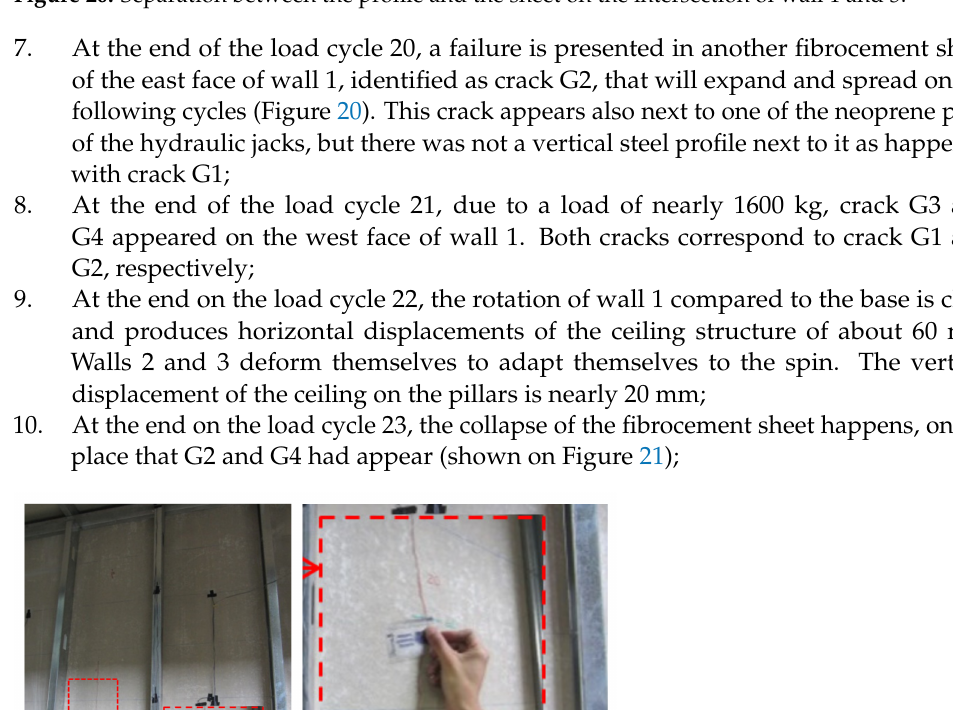
Figure 20. Separation between the profile and the sheet on the intersection of wall 1 and 3.